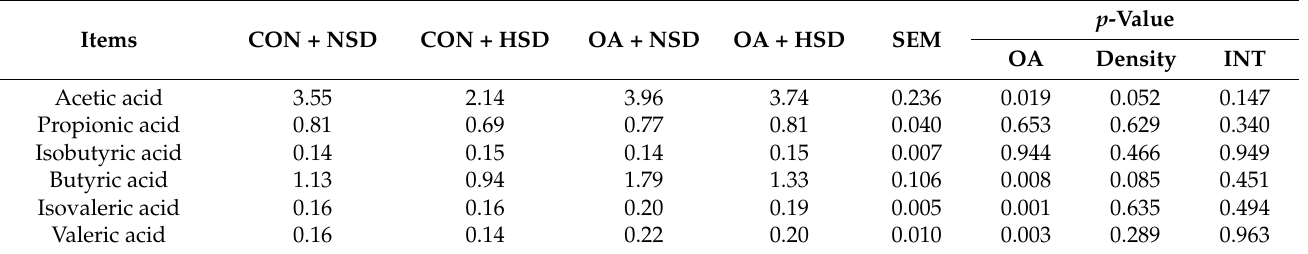
Table 6. Effects of organic acids on volatile fatty acids contents in broilers under high stocking density in grower phase (mmol/L) 1